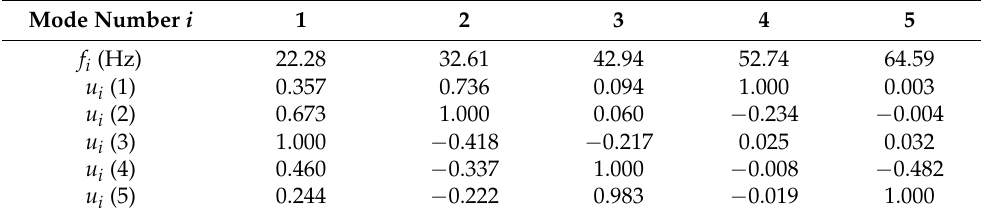
Table 2. Natural frequencies of original structure.